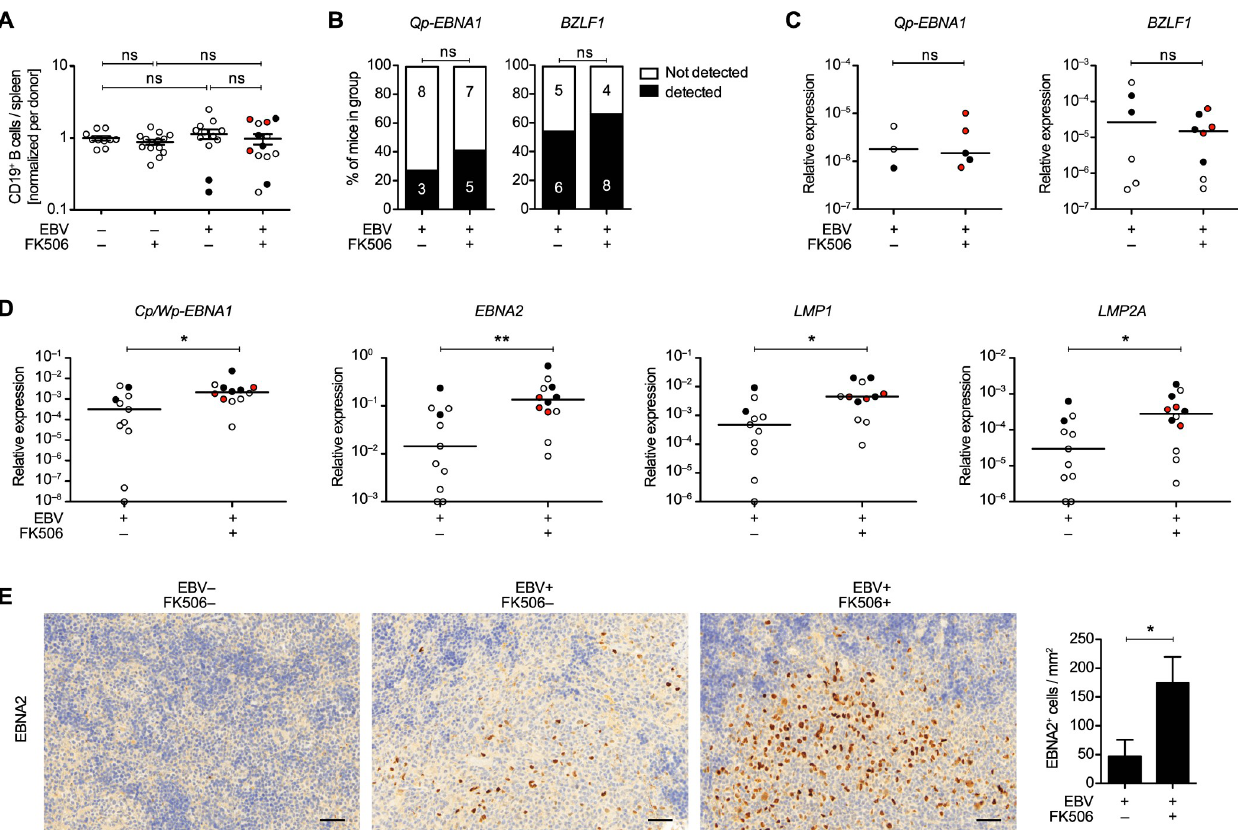
Fig 3. FK506 treatment enhances the expression of EBV latency II/III transcripts in B cells in vivo . A) Total splenic CD19 + cell counts are depicted for individual mice from three independent experiments relative to the mean of the EBV − FK506 – group. Mean ± SEM, unpaired t test with Welch’s correction. B-D) Composite data from three independent experiments with EBV + FK506 – (n = 11) and EBV + FK506 + (n = 12). B) EBV mRNA in CD19 + MAC-sorted splenocytes was quantified in triplicates for each mouse by RT-qPCR. Data is depicted as percent of mice per group with transcript levels above the detection threshold. P-values were calculated with Fisher’s exact test. C-D) Transcript expression is displayed relative to the two reference genes (geometric mean of GAPDH and SDHA ). EBNA, EBV nuclear antigen; LMP, latent membrane protein; Cp, Wp and Qp are latency-specific EBV promoters. Transcript values below the reliable quantification level are plotted on the X-axis. E) Representative IHC stainings and quantification of EBV nuclear antigen 2 (EBNA2) in splenic sections from EBV – FK506 – , EBV-infected (n = 7) and EBV-infected, FK506-treated (n = 10) huNSG-A2 mice from two independent experiments. Scale bar: 50 μ m. P-values were calculated with MWT, � : p < 0.05, �� : p < 0.01. See also S3 Fig.